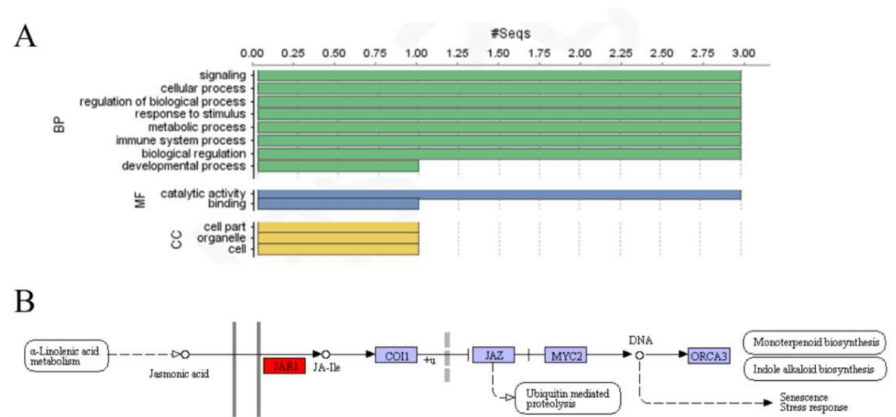
Figure 4. Information from gene ontology annotations and the KEGG pathway. ( A ) GO annotation for StGH3 proteins. BP, MF, and CC indicate Biological Process, Molecular Function, and Cellular Component, respectively. The numbers on the abscissa indicate the number of predicted proteins; and ( B ) the GH3 proteins are related to the KEGG pathway. StGH3.1, StGH3.5, and StGH3.12 are predicted to be part of the JA pathway. The red box is a functional site for of these three proteins according to prediction. COI1 is a receptor [41] which can combine with ASK ( Arabidopsis Skp-like protein) and AtRbx ( Arabidopsis ring-box protein) to form the complex SCF COI1 [42]. Jasmonate ZIM (JAZ) is a JA pathway suppressor. In the absence of JA, these proteins interact with MYC proteins to block their activity. The bHLH transcription factor MYC is a master regulator of the response to the JA pathway [43]. ORCA3 regulates basic and secondary metabolism of plants by JA induction